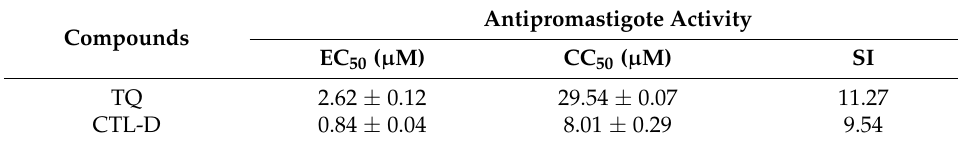
Table 1. Antipromastigote activity of TQ and CTL-D.